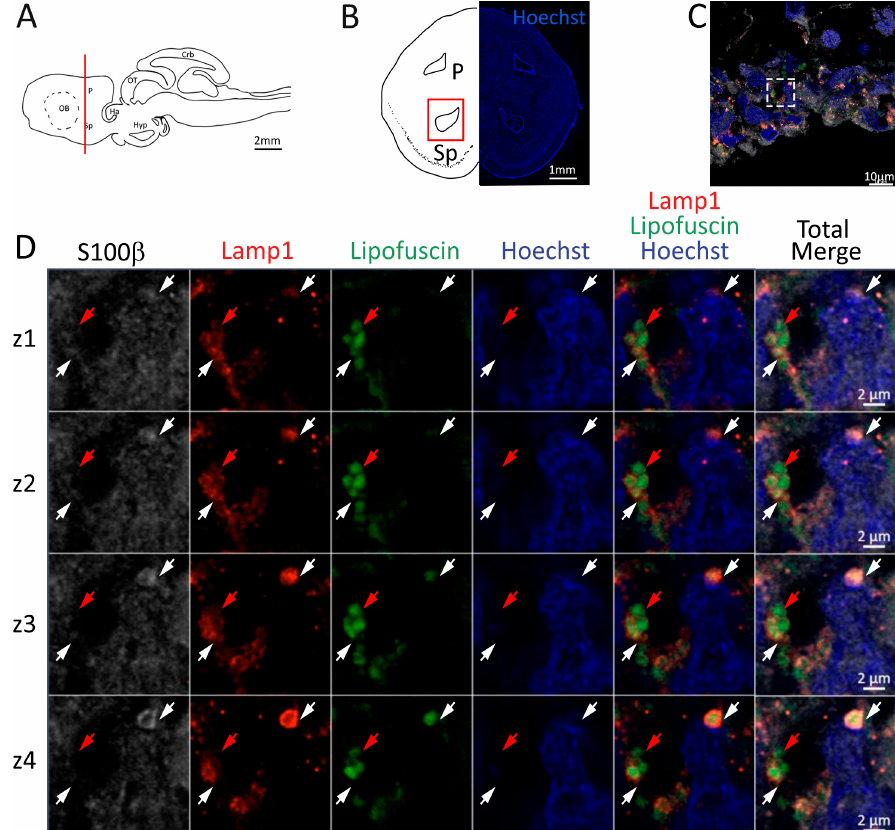
Figure 8. Presence of lipofuscin aggregates inside lysosomes in the posterior telencephalon of S. canicula . ( A ) Sagittal representation of S. canicula brain. The red line indicates the rostro-caudal localization of the section represented in the panel. ( B ) Coronal map of the posterior telencephalon. On the right, a real coronal section is stained with Hoechst 33342 to show nuclei distribution; on the left, a cartoon is drawn to indicate anatomical references. Red rectangle identifies the general area from which images are taken. ( C ) Area of the neurogenic niche where magnifications are taken from. ( D ) Lysosomes (Lamp1, red) containing lipofuscin (green) localized in radial glial cells (S100 β + , white) and are localized around the nucleus (Hoechst, blue). In the panel, four consecutive z planes are represented (z1–z4) to render the three-dimensionality of the inclusion. Each plane is acquired at 1 μ m step in the z-axis from the previous. Last column represents the overlay of all four channels. White arrows indicate the localization of lysosomes containing lipofuscin, red arrows indicate lipofuscin granules not included into lysosomes. Abbreviations: P: pallium, Sp: subpallium.